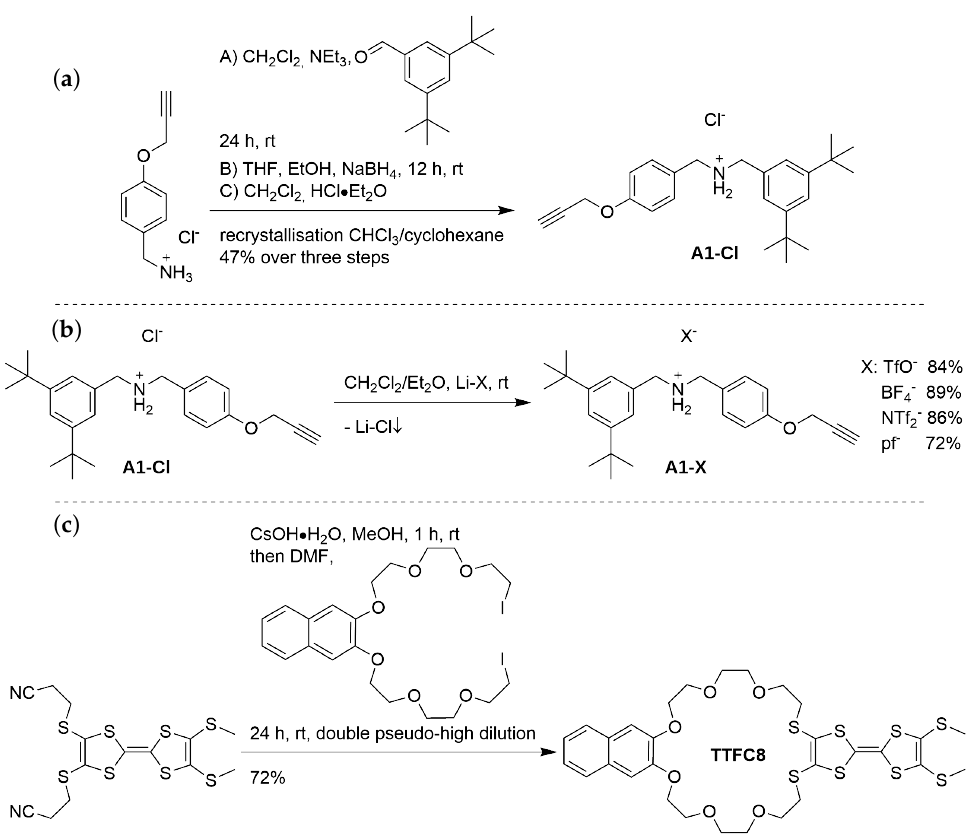
Et 2 O. The Et 2 O. The · ·